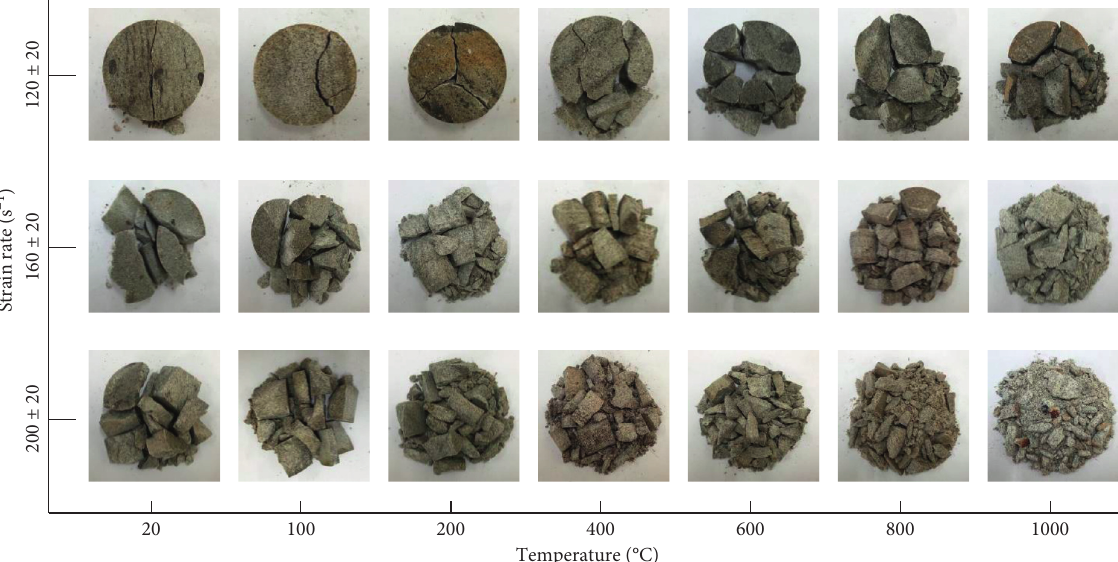
Figure 14: Dynamic failure mode of argillaceous sandstone after high temperature.